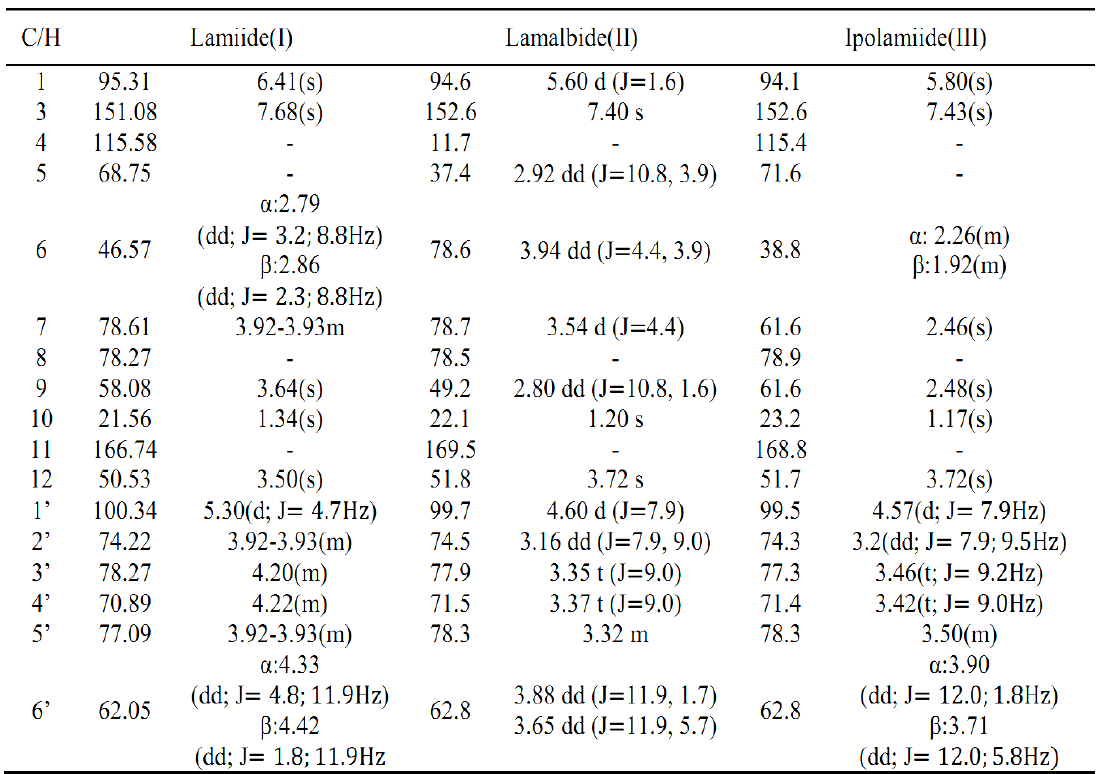
Table1. The 13 C and 1 H NMR spectroscopic data for Lamiide (I), lamalbide (II)